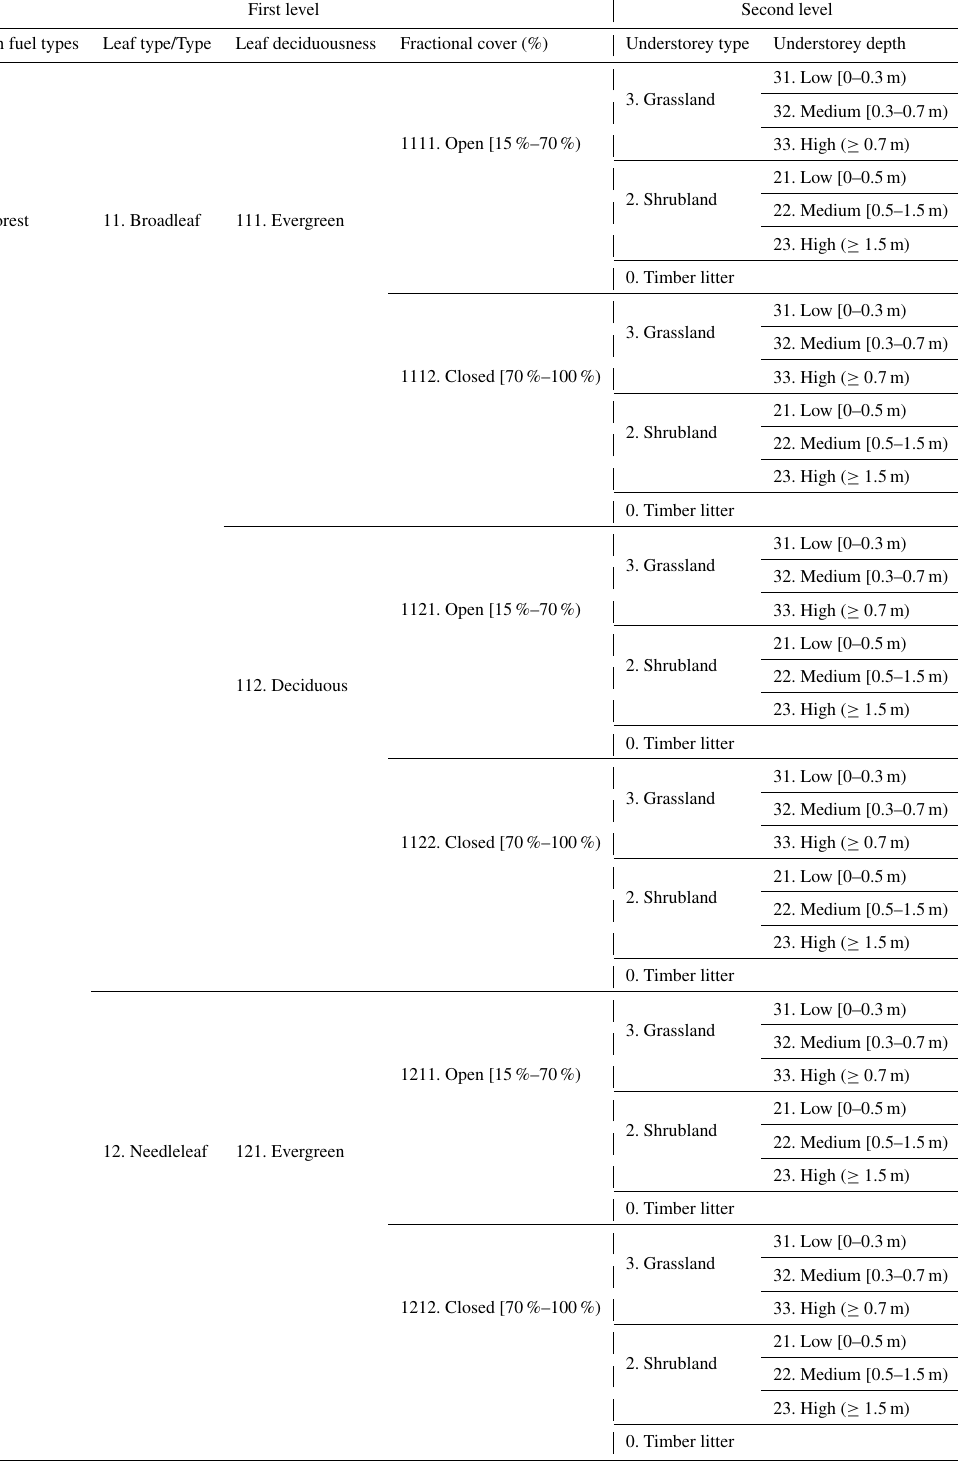
Table A1. The FirEUrisk hierarchical fuel classification